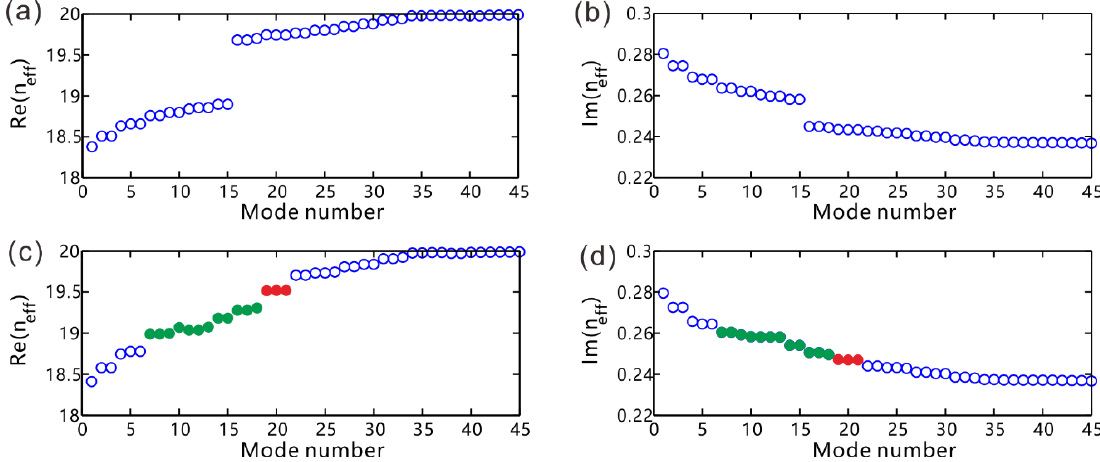
Figure 2. The effective mode index in the triangle nanowires. In ( a , b ), the spatial spacing in the nanowires is d 1 = 400 nm and d 2 = 320 nm. In ( c , d ), the spacing is reversed and d 1 = 320 nm and d 2 = 400 nm. The green dots represent the edge mode while the red dots denote the corner mode.